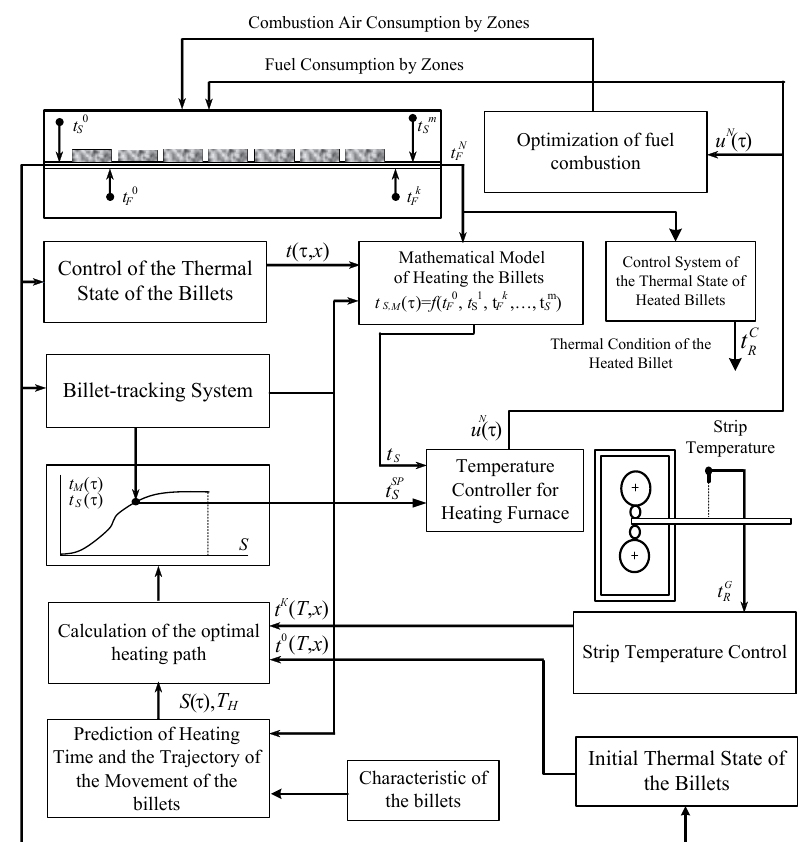
Figure 4. Structural diagram of the optimal energy-saving heating control system for a pass-through heat-treatment